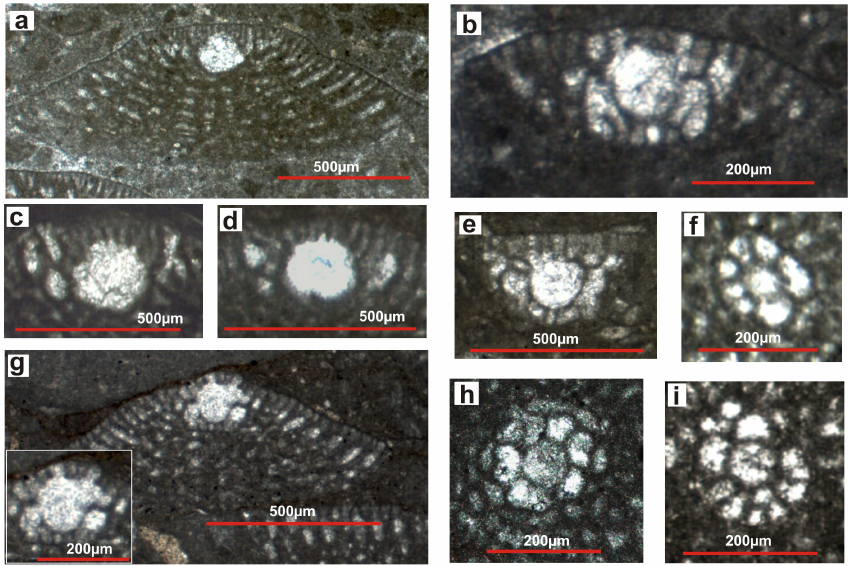
Fig. 5. (a) Palorbitolina lenticularis , axial section through the embryonic apparatus (Mt. Coccovello, sample CV 71.7); (b) Mesorbitolina texana , axial section through the embryonic apparatus; (c–d) Palorbitolina lenticularis , axial section through the embryonic apparatus (Mt. Coccovello, CV 65.4a); (e) Mesorbitolina texana , axial section through the embryonic apparatus (Mt. Coccovello, CV 77.9a); (f) Mesor- bitolina texana , subtransversal section of the embryonic apparatus, slightly oblique through the subembryonic zone (Mt. Coccovello, CV 77.9a); (g) Mesorbitolina parva , axial section through the embryonic apparatus, with detail of the embryonic apparatus (Mt. Coccovello, CV 77.9a); (h) Mesorbitolina parva , transversal section through the embryonic apparatus (Mt. Tobenna, TB 8.3); (i) Mesorbitolina parva , subtransversal section of the embryonic apparatus, oblique through the subembryonic zone (Mt. Coccovello, CV